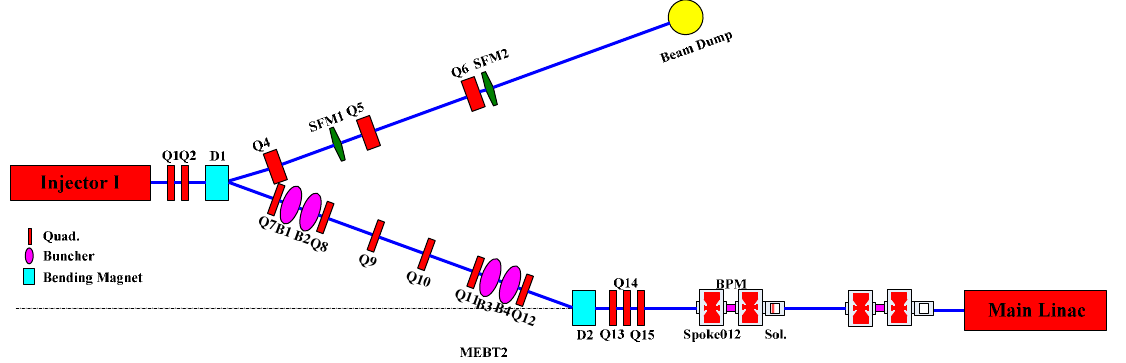
FIG. 13. Schematic of the MEBT2 (only the upper part of two symmetric branches is shown).